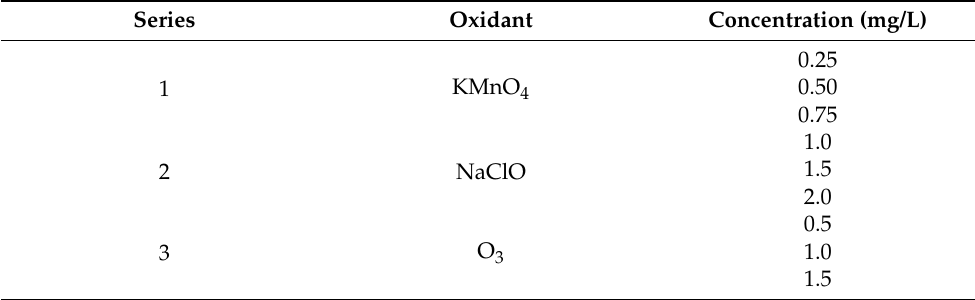
Table 1. Concentrations of the oxidants.